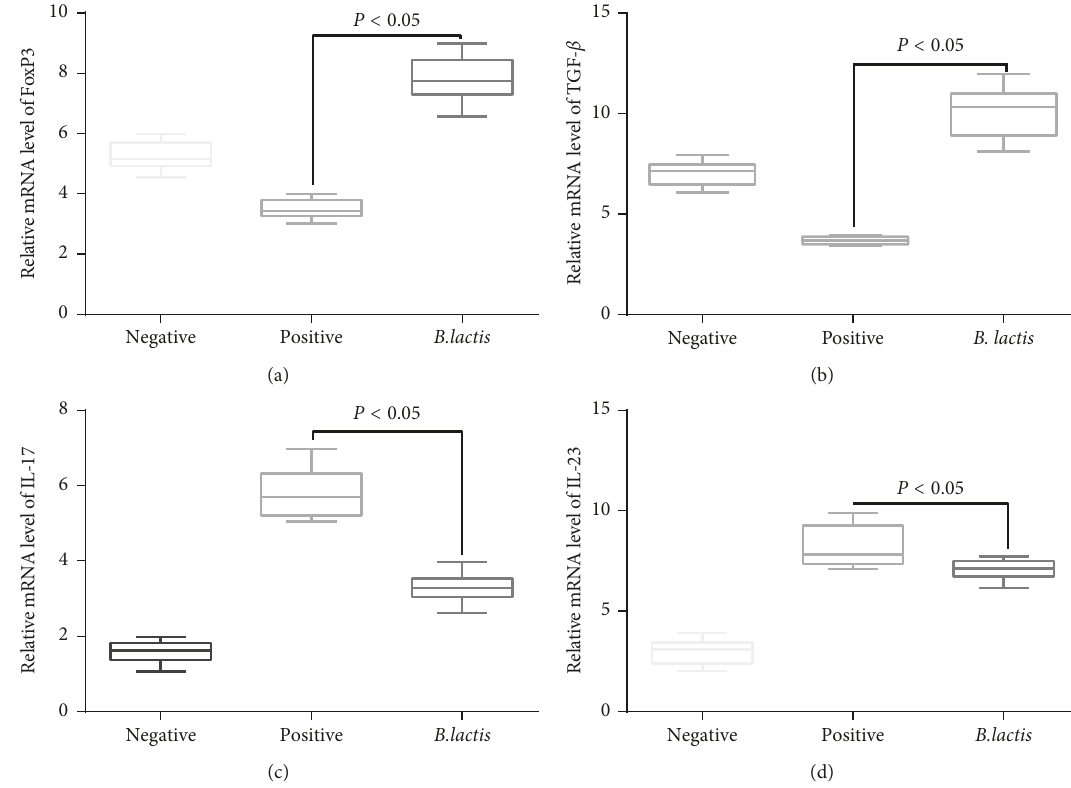
Figure 5: The effects of B. lactis on relative mRNA levels of Treg- and Th17-related cytokines in mouse allergy models. (a) The effects of B. lactis on mRNA levels of FoxP3 in mouse allergy models. (b) The effects of B. lactis on relative mRNA levels of TGF- β in mouse allergy models. (c) The effects of B. lactis on relative mRNA levels of IL-17A in mouse allergy models. (d) The effects of B. lactis on relative mRNA levels of IL-23 in mouse allergy models. The statistical difference was significant if P